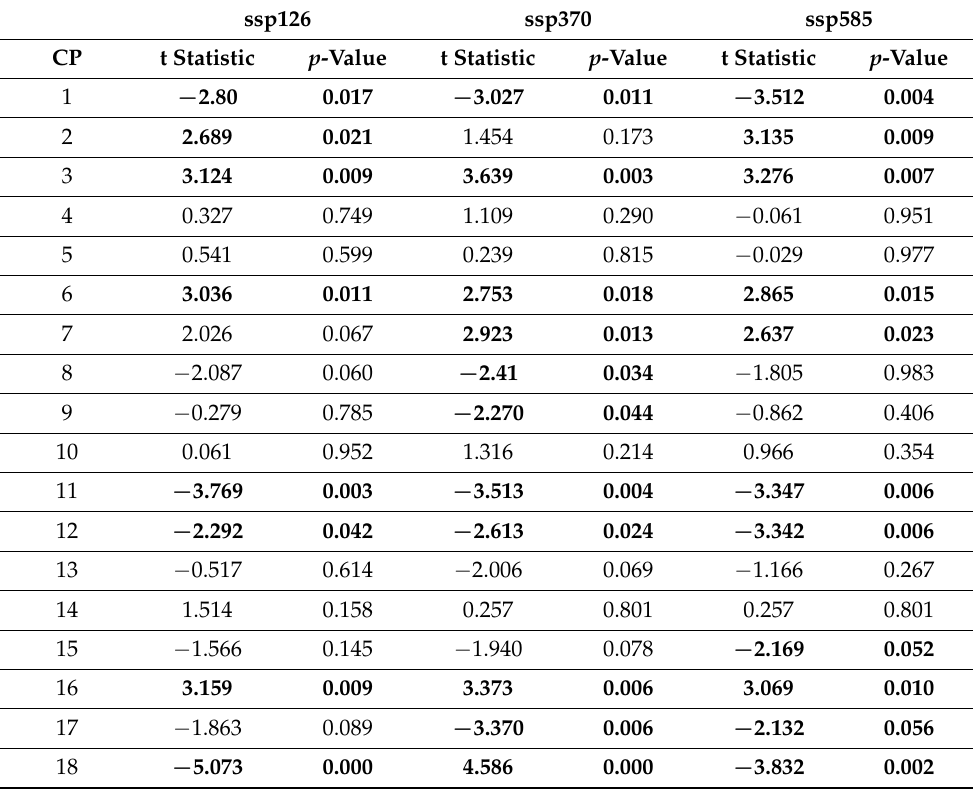
Table 2. T-test statistics for each of the CPs and